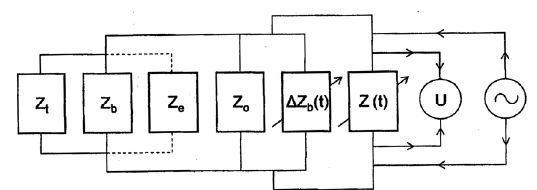
Fig. 2. Schematic of a multi-compartmental parallel conduction model of the thorax. The transthoracic electrical impedance Z(t) to an applied AC field represents the parallel connection of a quasi-static base impedance Z 0 and a time-dependent component of the blood impedance, ∆Z b (t). Z 0 represents the parallel connection of all static tissue impedances, Z t , and the static component of the blood resistance, Z b . Z e represents the quasi- static EVLW compartment. A voltmeter (U) and AC generator (~) are shown. From reference 37.